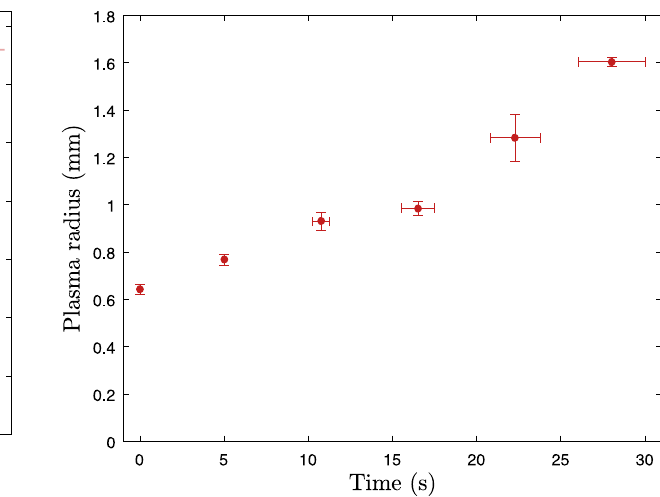
Fig. 5 Evolution of the e + temperature following the laser cooling frequency sweep. 1.4 × 10 6 e + and 4.7 ± 0.1 × 10 5 Be + ions were used. Turning the cooling laser off (red points) results in the e + heating at a rate of ~25 K s − 1 , before their temperature saturates at around 125 K. If, however, the cooling laser is kept on at a fi xed detuning of − 7 Γ , the fi nal detuning in the frequency sweep, the e + can be kept at 6.7 ± 0.3 K for over 20 s (blue points). The vertical error bars correspond to the standard error on the mean temperature for each hold